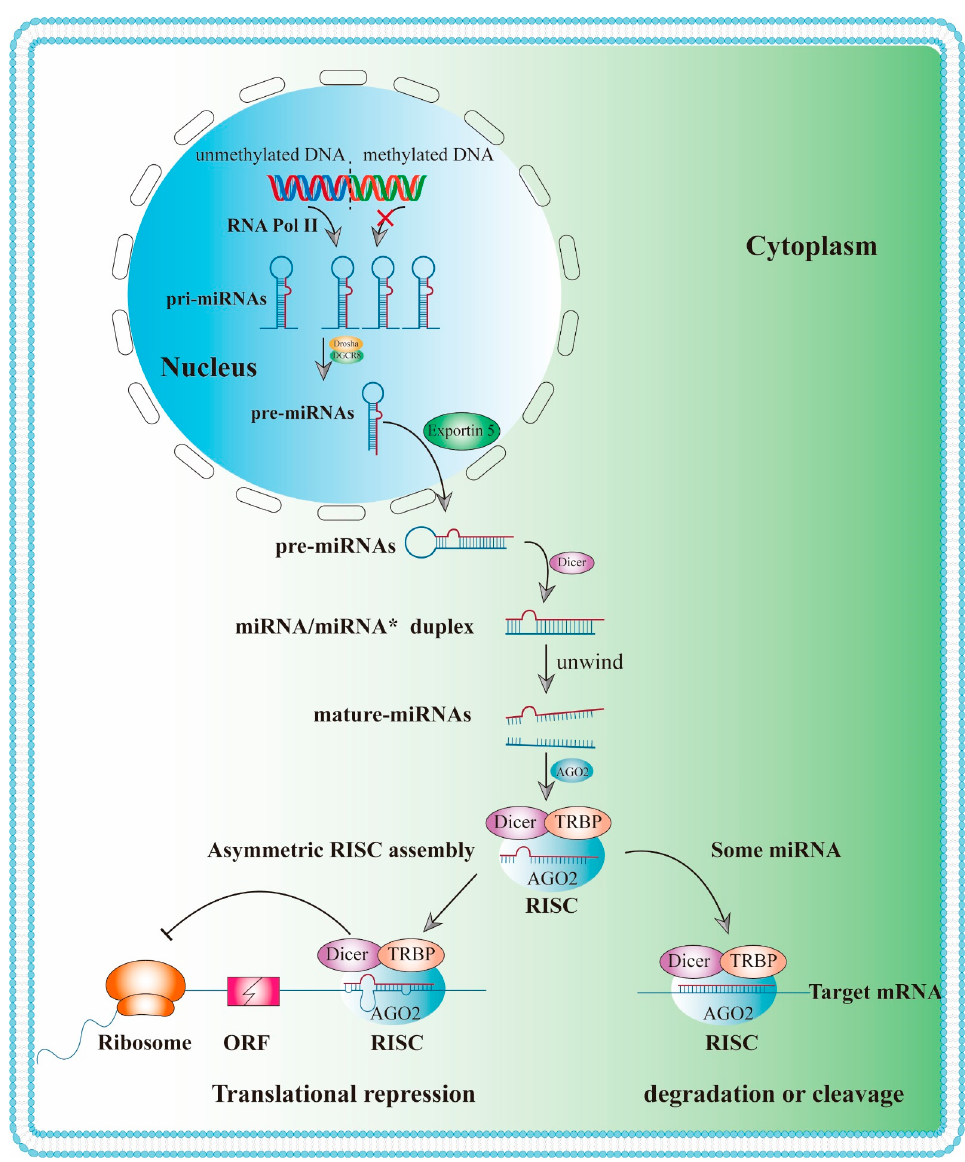
Figure 2. Biogenesis and biological function of miRNAs. RNA Pol II : RNA polymerase II; DGCR8 : DiGeorge syndrome critical region 8; pri-miRNAs : primary miRNA; pre-miRNAs : microRNAs precursor; RISC : RNA-induced silencing complex; TRBP : TAR RNA binding proteins; AGO2 : Argonaute 2; ORF : open reading frame.